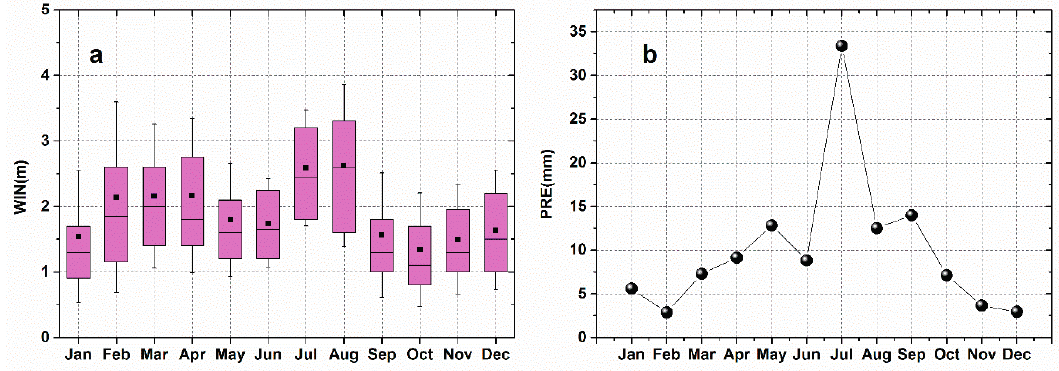
Figure 6. Meteorological condition in Wuhan during the experiment period. ( a ) Box plots of seasonal variation of wind speed means (solid black square), median (horizontal line within the box), 25th and 75th percentiles (upper and lower edges of the box, respectively), and standard deviation (shorter horizontal lines) for different months; ( b ) average monthly